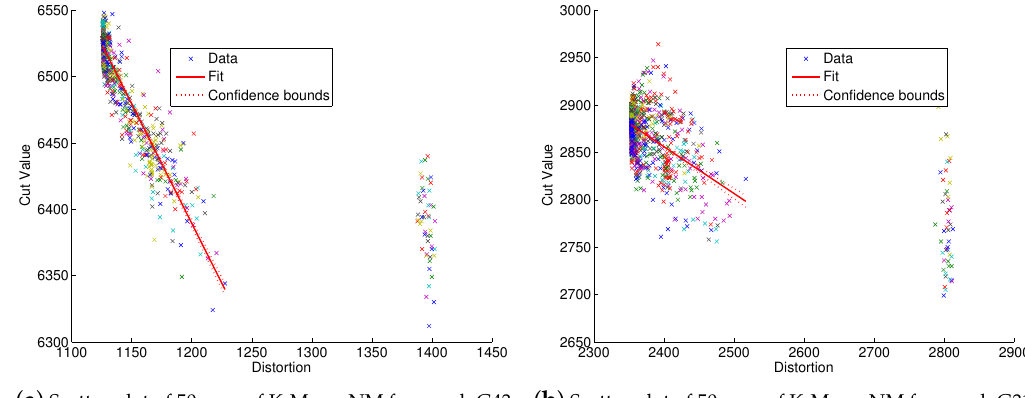
( b ) Scatter plot of 50 runs of K-MeansNM for graph G31. Figure 1. Exploration of the path of 50 iterations of K-MeansNM on the distortion weight of the corresponding cut. The diagram shows all values generated while running the k -means. Points at the bottom right of the plot are the starting points and thus the results of Goemans–Williamson rounding; meanwhile, points at the top left are the end points. At each step of K-MeansNM, the points move to the left until the algorithm finds a local minima of distortion. The red line is a linear fit of all the points after the second step of k -means. These show a clear correlation between cluster distortion and cut